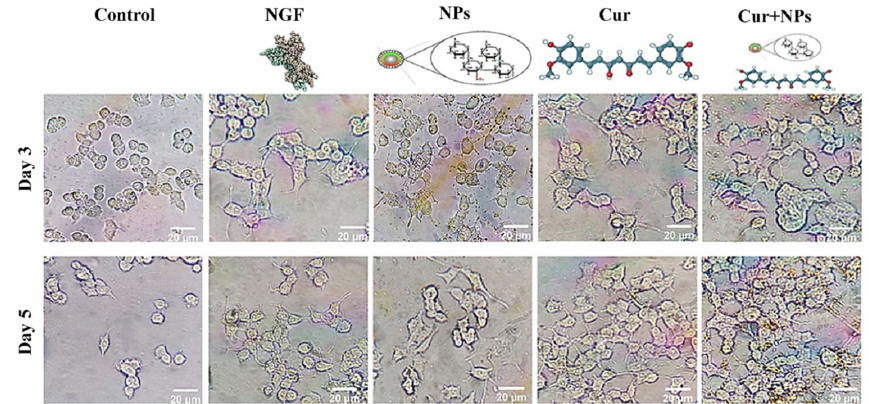
Figure 4. Typical images of differentiated PC12 cells. Microscopic images of differentiated PC12 cells 3 and 5 days after treatment with NGF (50 ng/mL), SPIONs (20 µ g/mL), curcumin (Cur, 20 µ M), and Cur+SPIONs (with a concentration of 20 µ M for Cur, and the concentration of 20 µ g/mL for SPION).